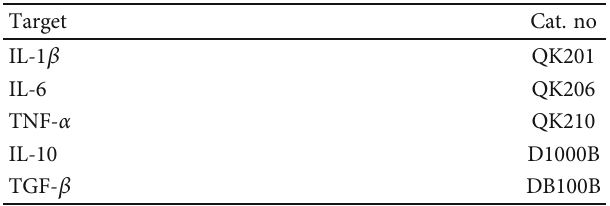
Table 1: Catalogue numbers of the ELISA kits. Target Cat.